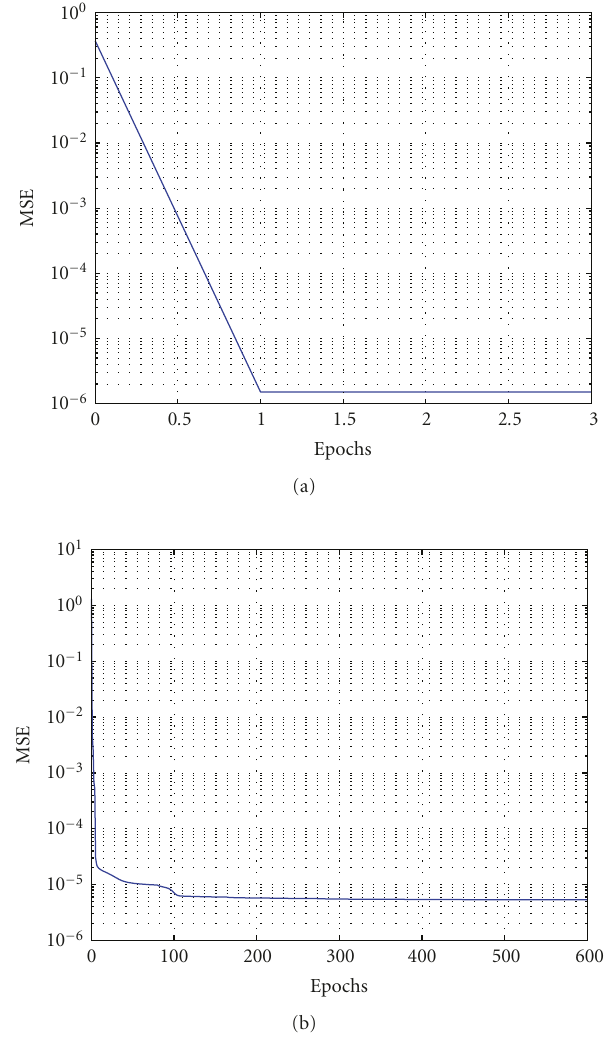
Figure 23: (a) LN learning sequence and (b) NLN learning sequence.